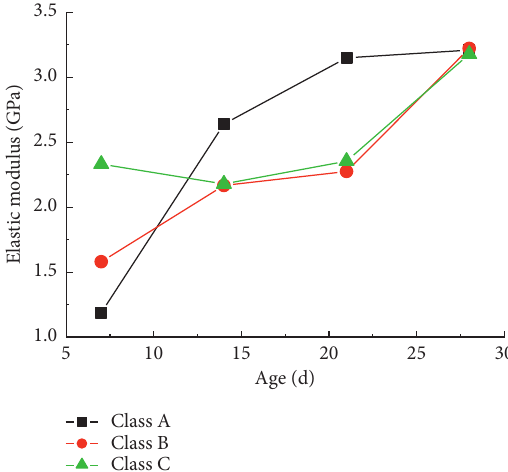
Figure 8: Elastic modulus curve of colloid cement paste